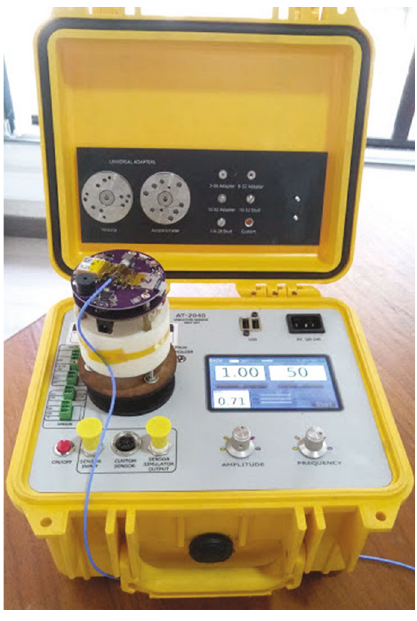
Figure 14: Simple-2 module installation detail in the AT-2040 Agate Shaker for sinusoidal vibration